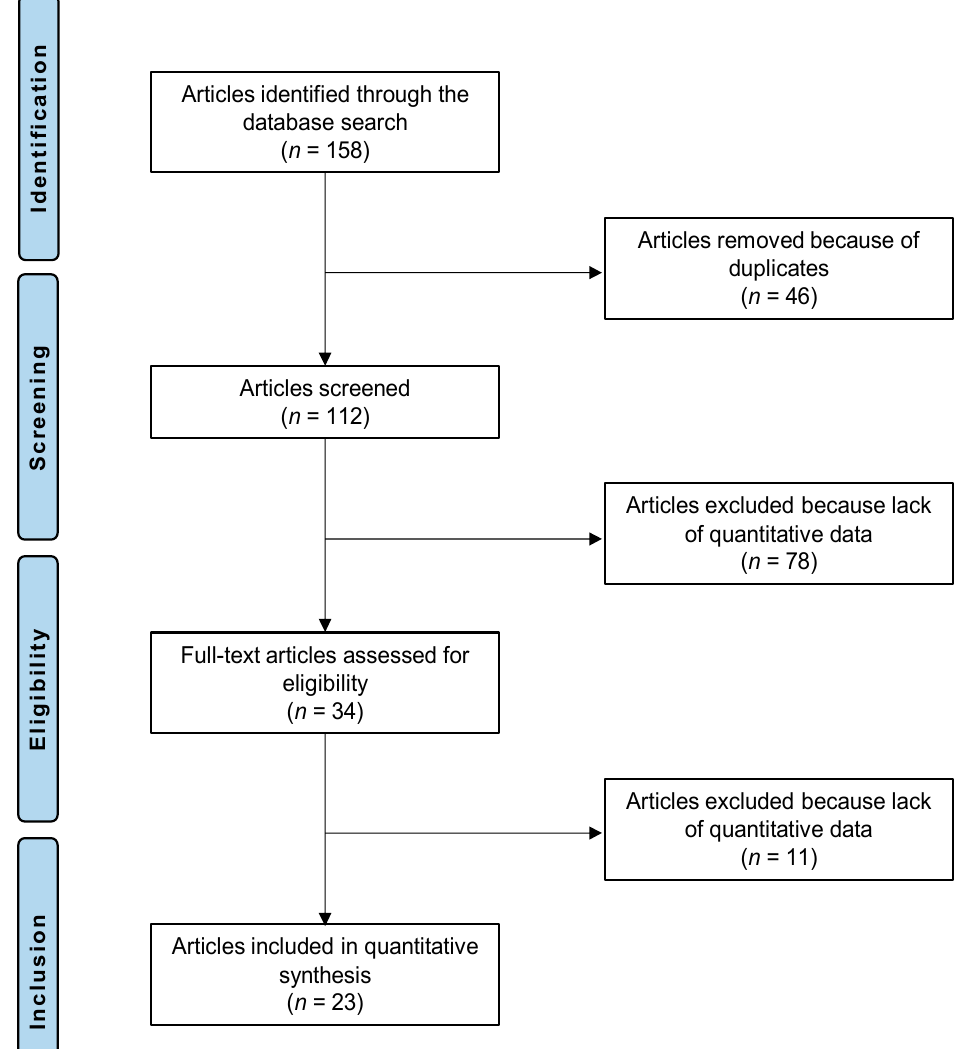
Figure 1. PRISMA flow diagram of the present systematic review.